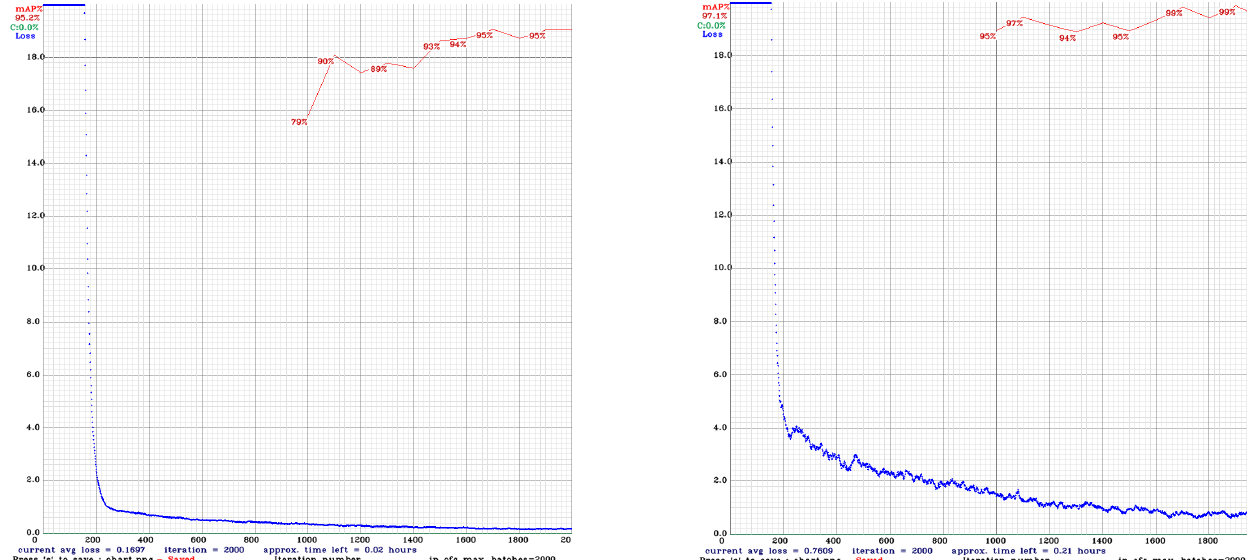
Figure 6. Loss and mAP in the custom YOLOv4-tiny model and Loss and mAP in the custom YOLOv4 model. Figure 7 shows the detection using MaskRCNN model and the YOLOv4 model. Whereas, in Figure 8 shows the detection using YOLOv4-tiny model.